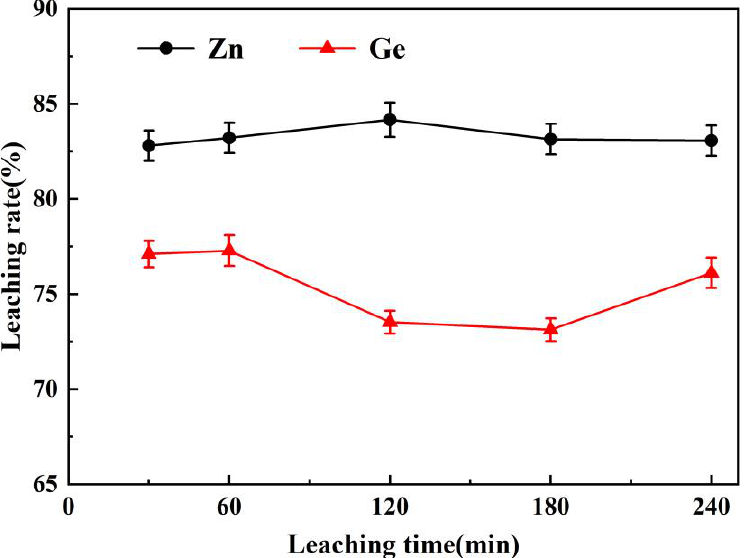
Figure 7. Effect of leaching time on metal leaching rate (L/S mass ratio = 5:1, initial acidity = 160 g·L − 1 , leaching temperature = 90 °C, and stirring speed = 400 r·min − 1 ).